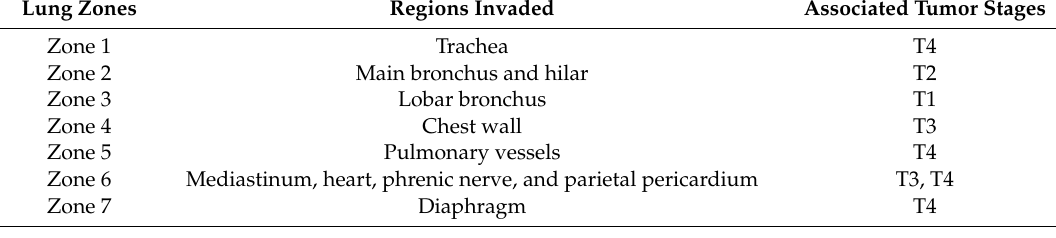
Table 2. Dividing di ff erent zones.